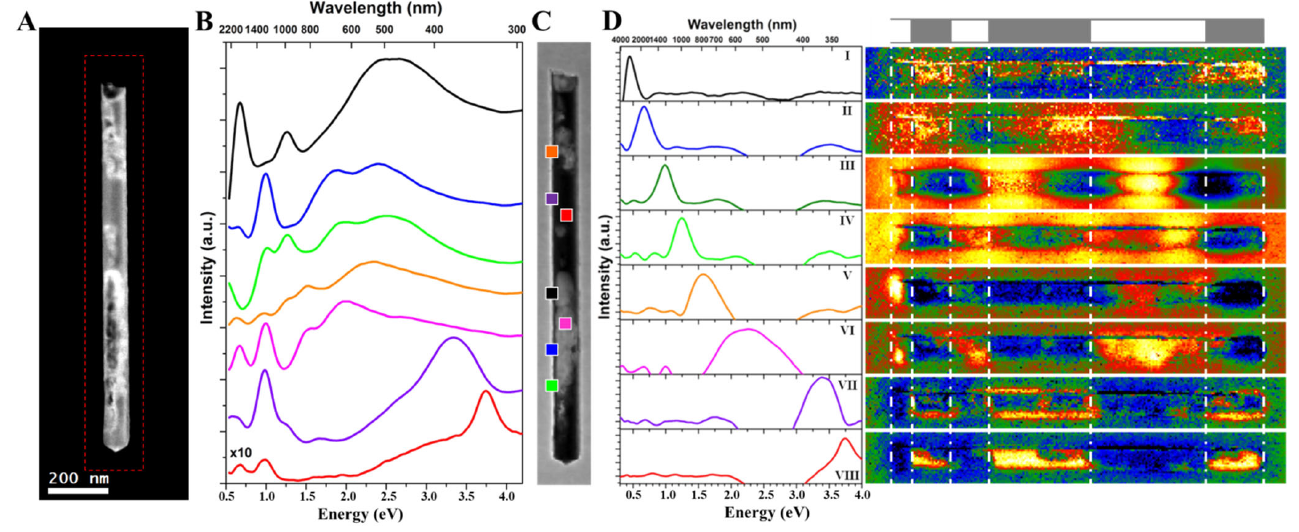
Figure 4. Plasmonic properties of a hybrid AuAg nanotube. ( A ) HAADF ‐ STEM micrograph of the hybrid AuAg nanotube which is 89 nm in diameter and 1.24 μ m in length. The area of the EELS SI is indicated with a red rectangle. ( B ) Background subtracted selected area EEL spectra of different locations marked in ( C ), which is the EELS SI taken from the red rectangle in ( A ). ( D ) The spectra and corresponding abundance maps of eight plasmonic components obtained by VCA processing. Hollow and solid sections are marked with white dashed lines.